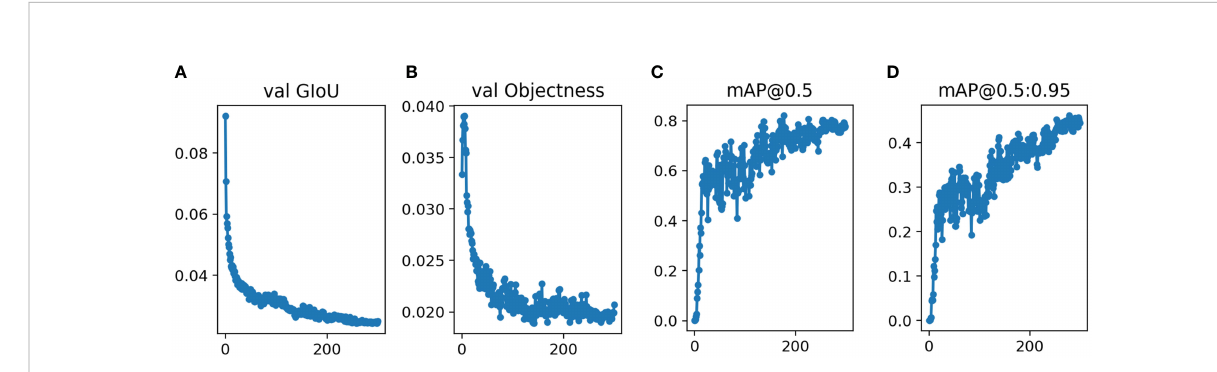
FIGURE 3 Performance of Yolov5s network structures in the validation datasets for pancreatic tumor diagnoses (A) GIoU Loss (B) Objectness Loss (C) mAP0.5 (D)